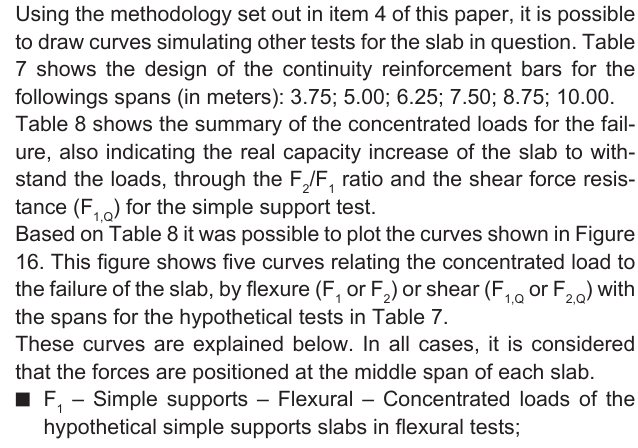
Figure 14 – Cross section of the tested slabs (units in millimeters): a) simple section formed only by the slab;